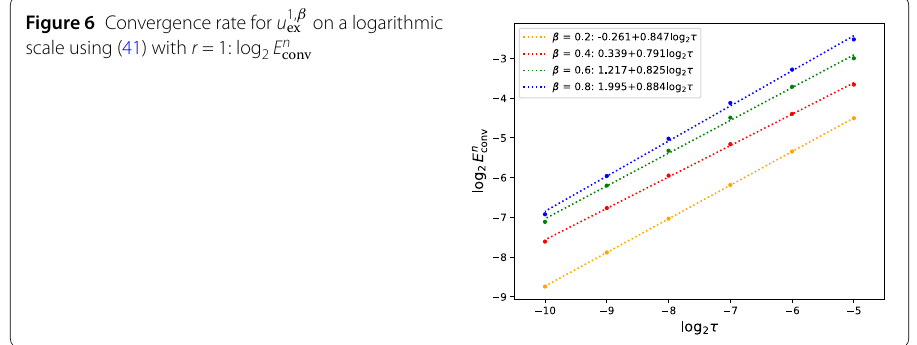
Figure 6 Convergence rate for u 1, β ex on a logarithmic scale using (41) with r = 1: log 2 E n conv